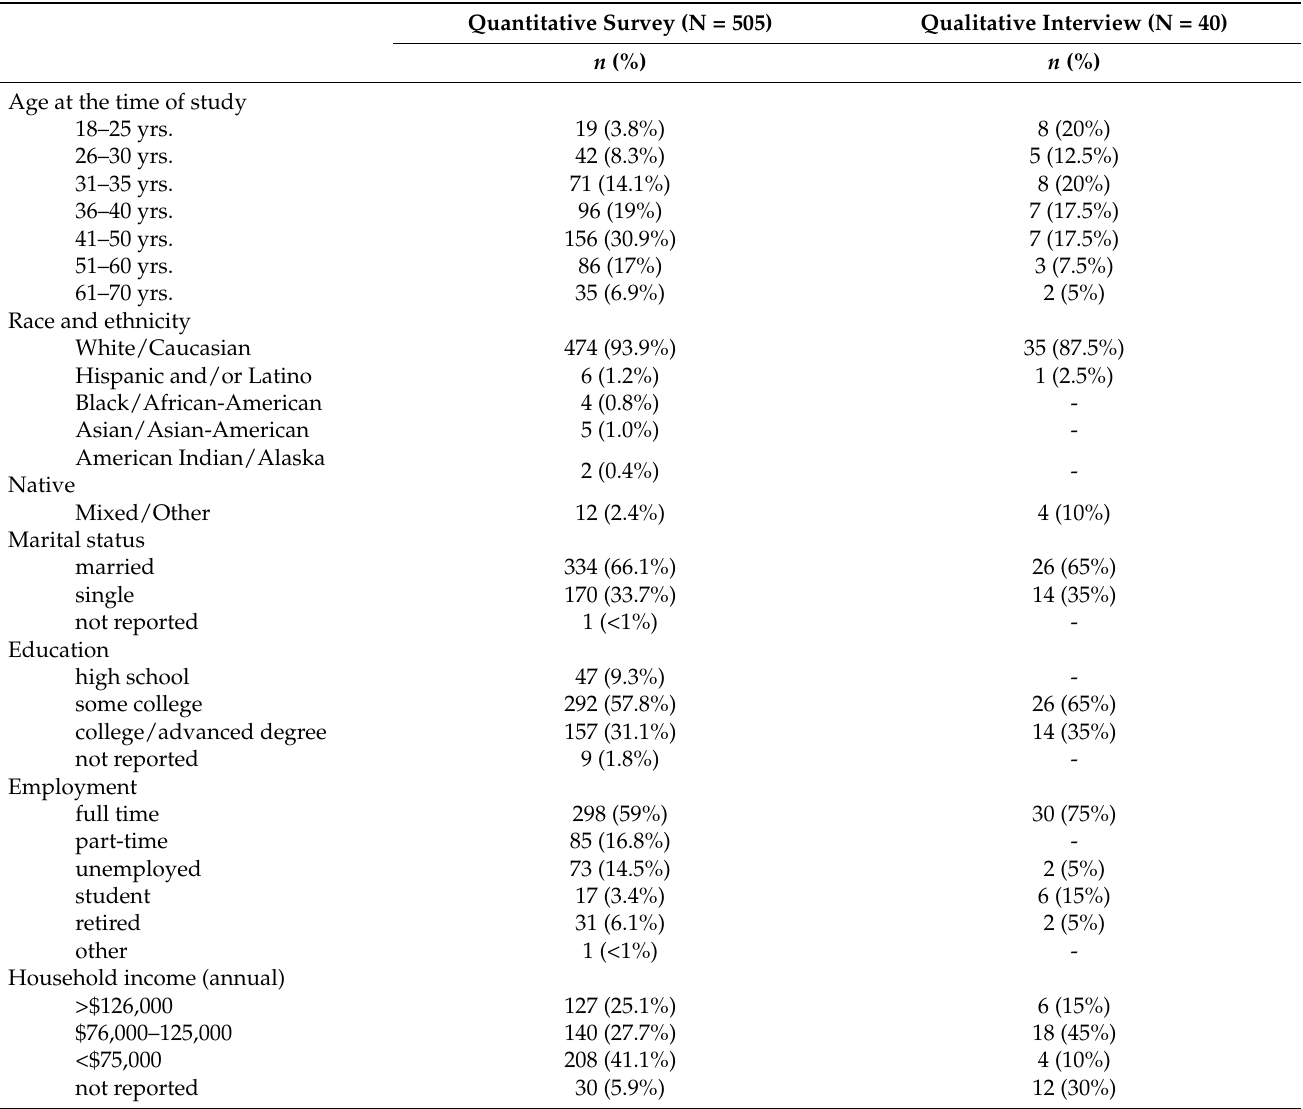
Table 1. Sociodemographic of the study